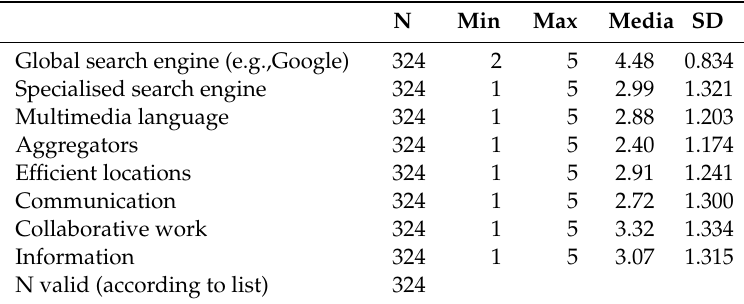
Table 5. Access to and use of information.